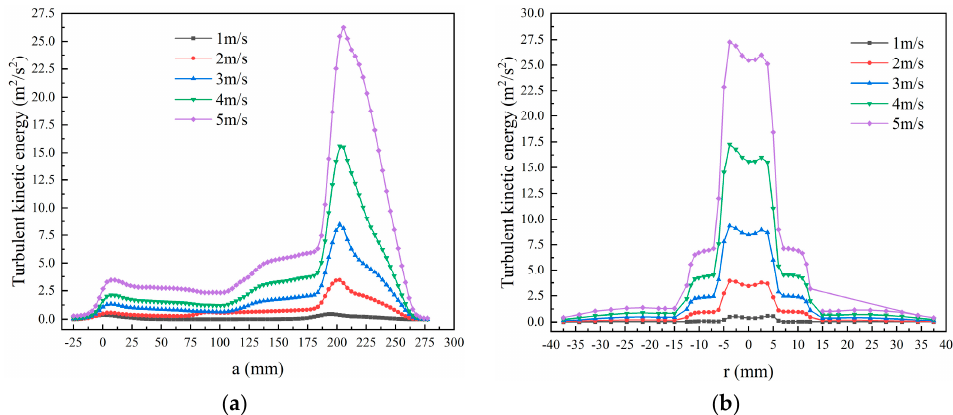
Figure 11. Turbulent kinetic energy. ( a ) Axial distribution of turbulent kinetic energy ( b ) Distribution of turbulent kinetic energy at z 3 .